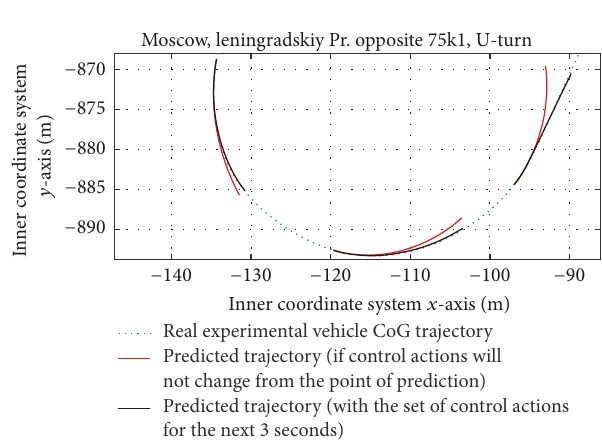
rate and its derivative, steering wheel angle and its derivative, and type of road under each wheel and corresponding sets of control actions over the next 3 s). The dataset was transformed into a multidimensional array for use in the autonomous vehicle motion planning system (Operational level) during driving along a fixed trajectory. This vehicle tra- jectory prediction method can be used in real-time systems for collision